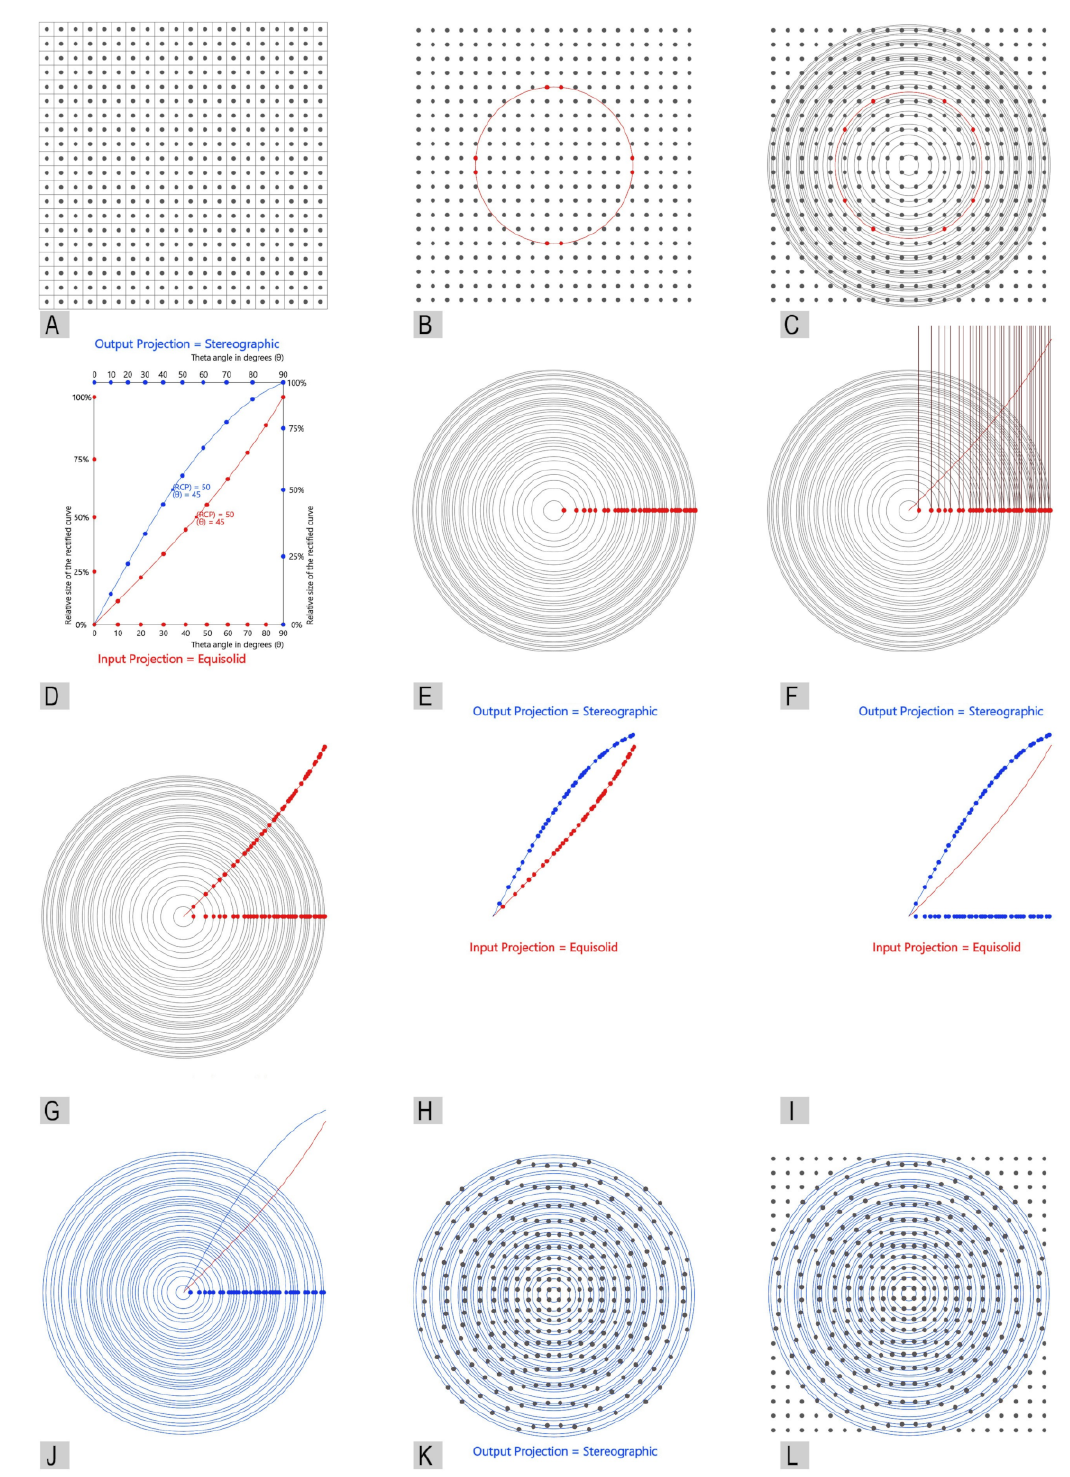
were remapped to the blue curve creating the new blue points as shown in Figure 7H. These new points from the blue curve was projected back onto the X axis (see Figure 7I).